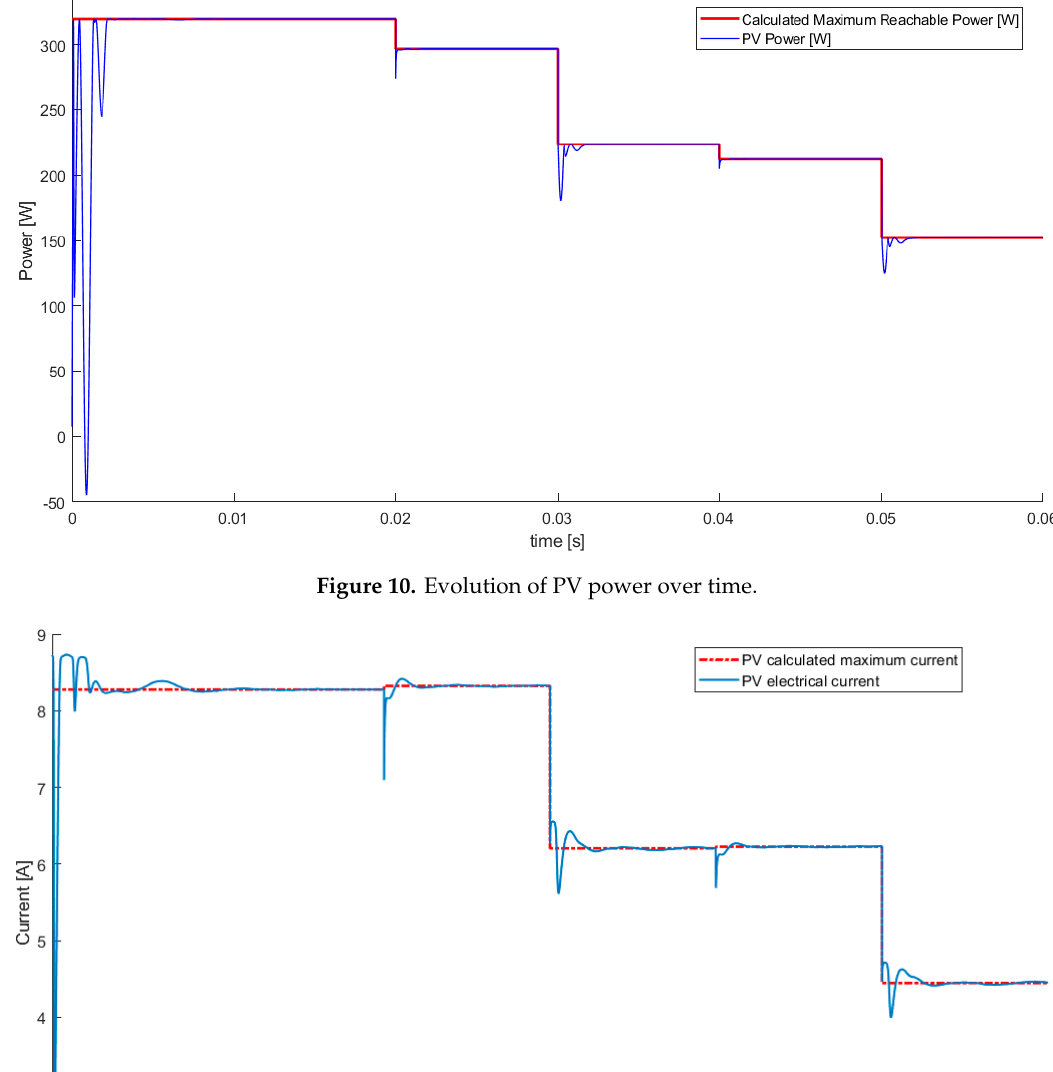
Figure 9. Dynamic of the solar radiation and temperature over time.